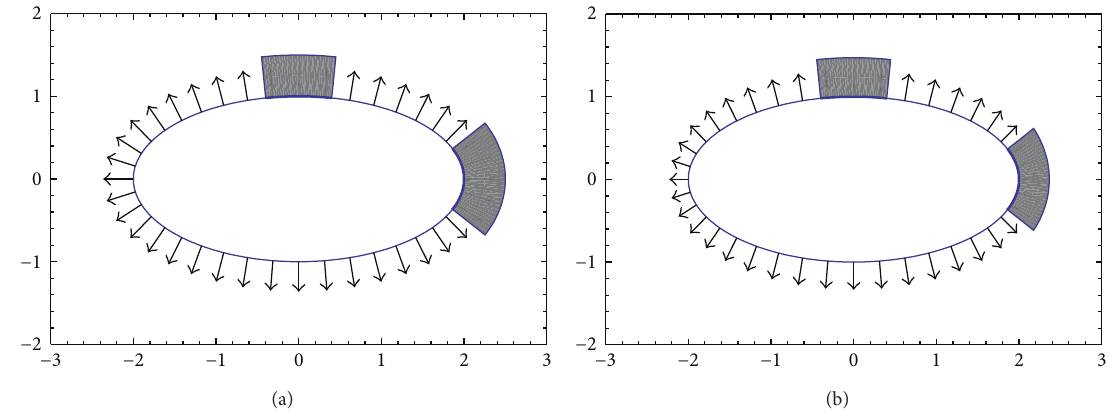
Figure 2: The velocity fields of two types of normal evolution for the elliptical initial front are shown. (a) The velocity field of a constant speed normal evolution is plotted. Two segments corresponding to the shaded regions have the same arc-length. Due to the curvature effect, their areas are different. (b) The velocity field of an equivolumetric evolution is plotted. Two regions occupied by the velocity field corresponding to the segments of the same arc-length are the